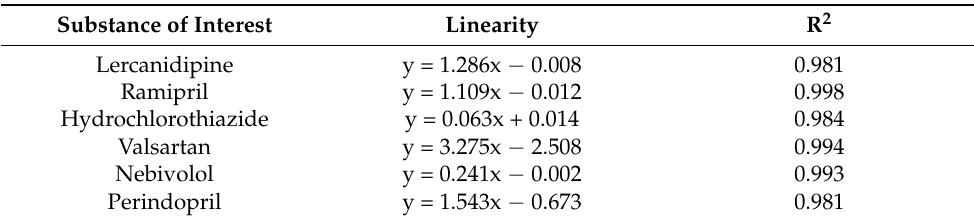
Table 3. Linear regression equations for the test drugs determined with the SFPE (solvent front position extraction) procedure.